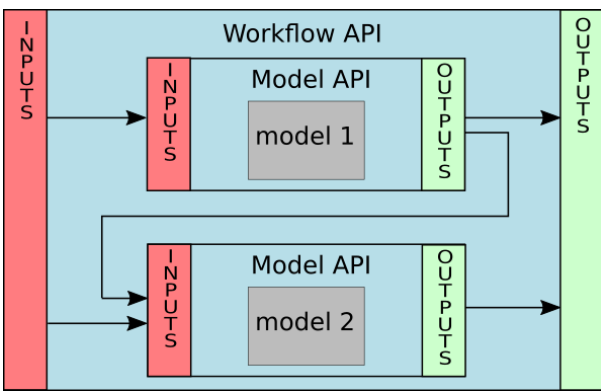
Figure 1. Example of a workflow structure.